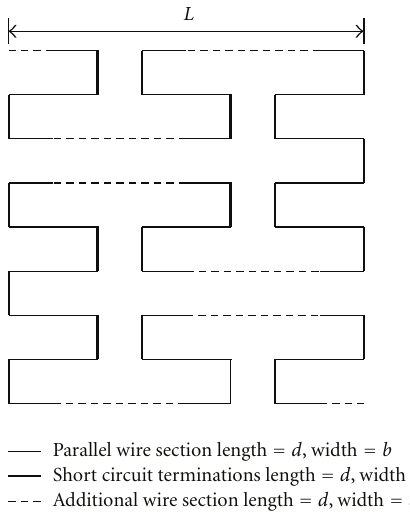
Figure 2: Composition of Peano fractal wires for calculating the resonant frequency.